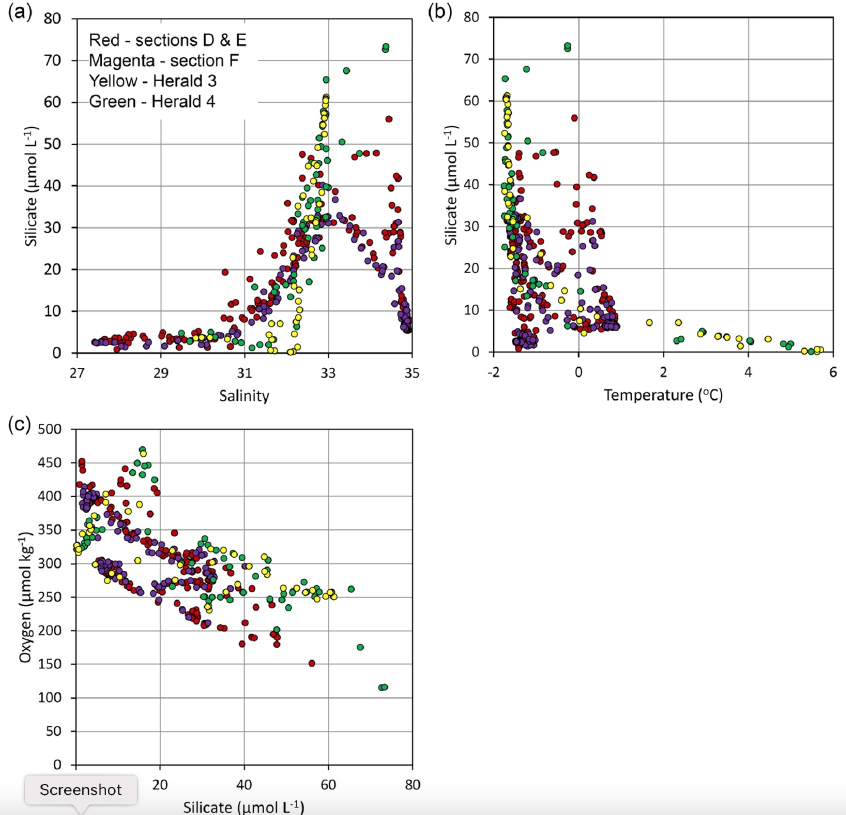
Figure 14. Plots of SWERUS-C3 East Siberian Sea shelf-break data compared with those of Herald Canyon: silicate versus salinity (a) , silicate versus temperature (b) , and oxygen versus silicate (c) . Locations of the stations are noted in the map of Fig.